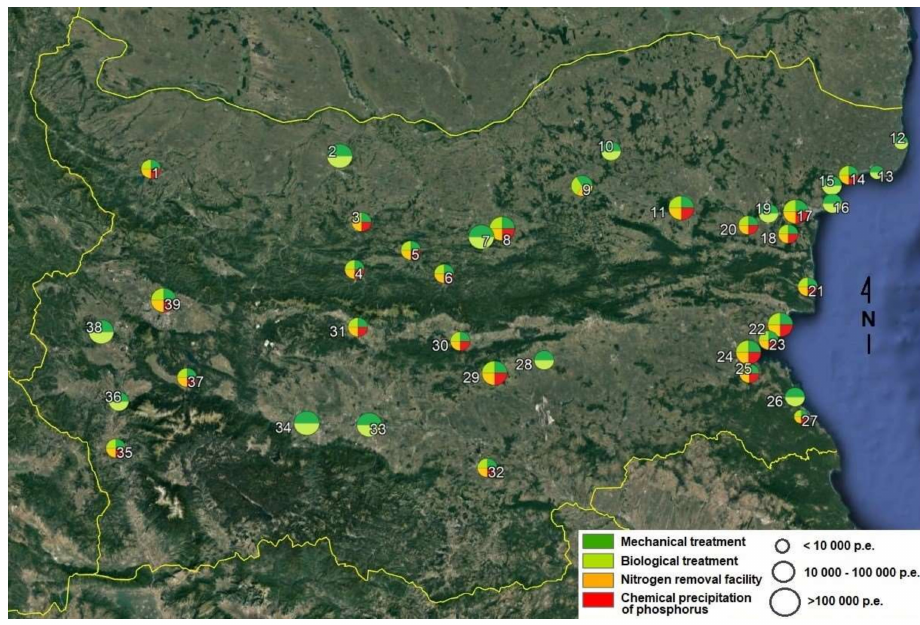
Figure 4. Sampling